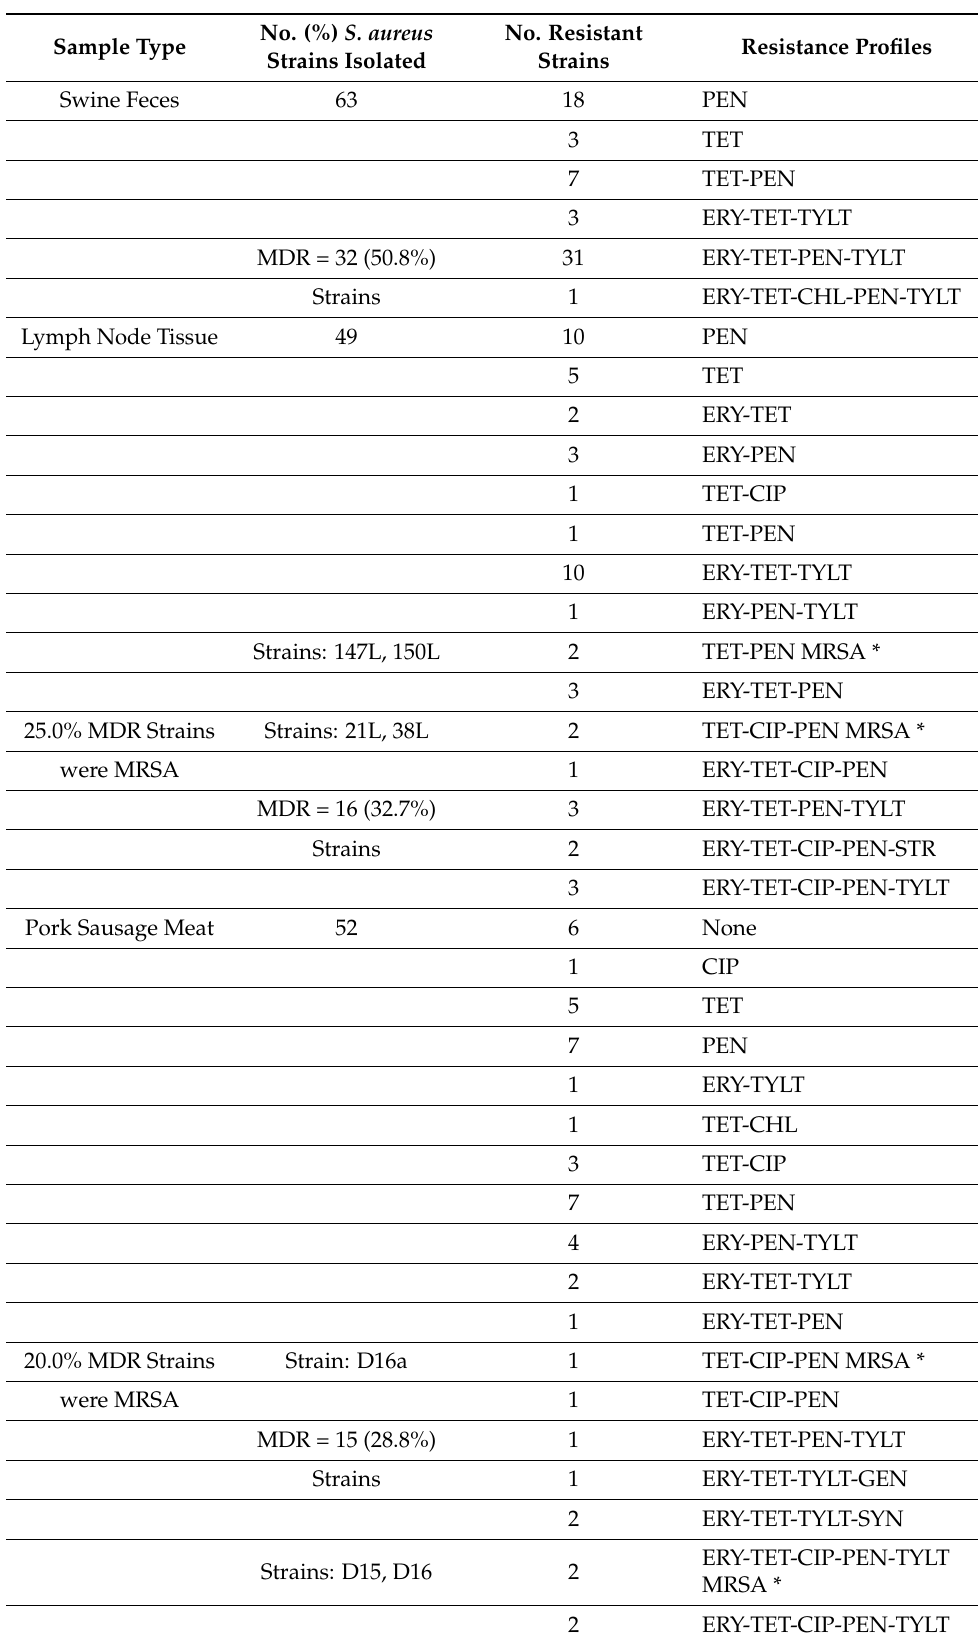
Table 2. Antimicrobial resistance and resistance profiles among 164 Staphylococcus aureus strains isolated from swine feces, swine mandibular lymph node tissue, and commercial pork sausage